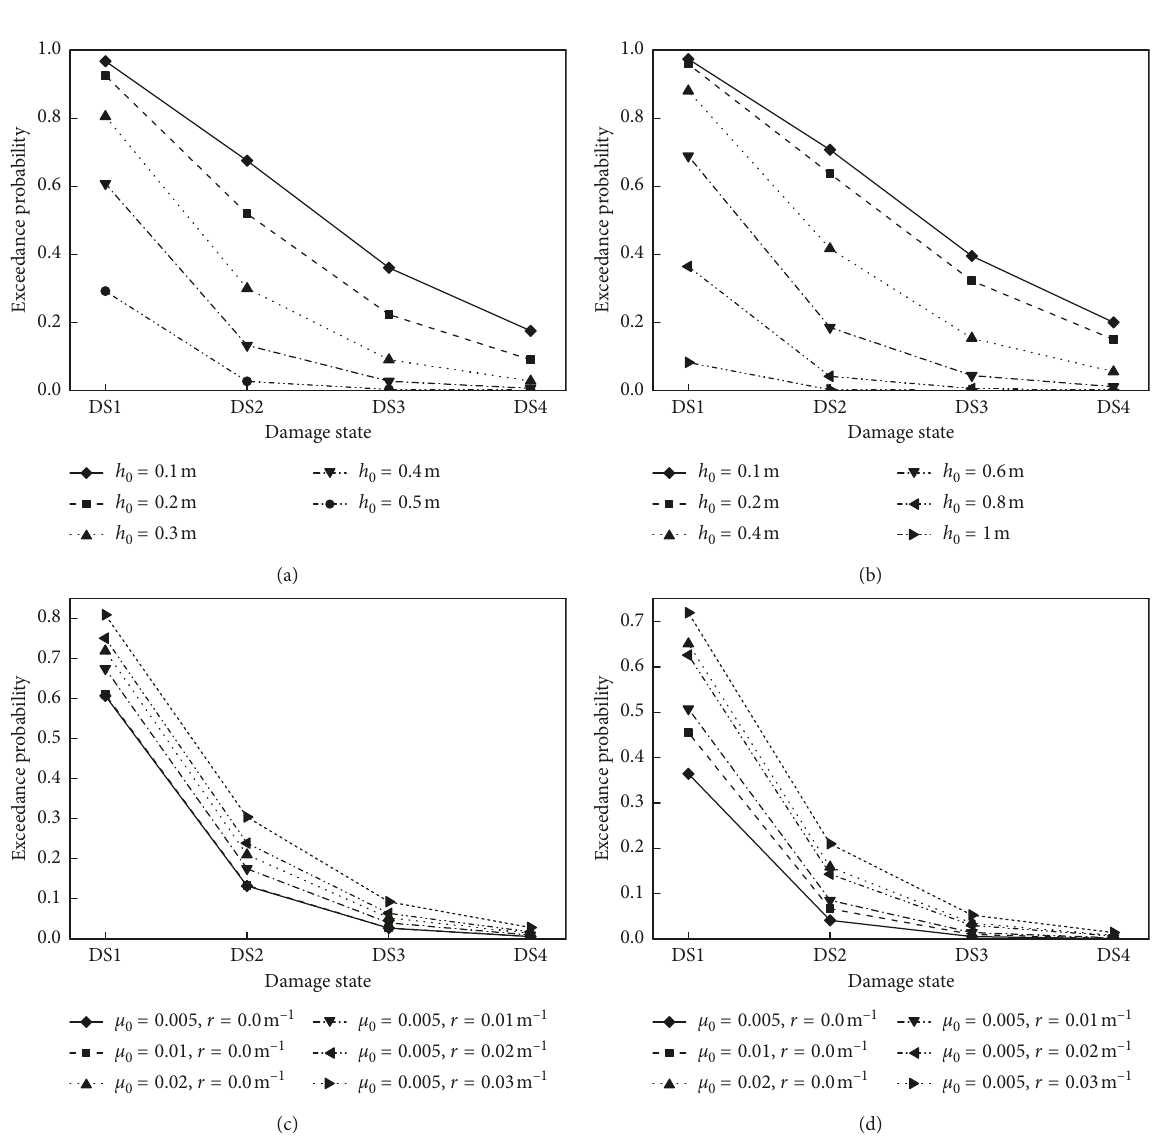
200kN/m, C (cid:31) 1 . 0m, h 0 0 . (cid:31) (cid:31)